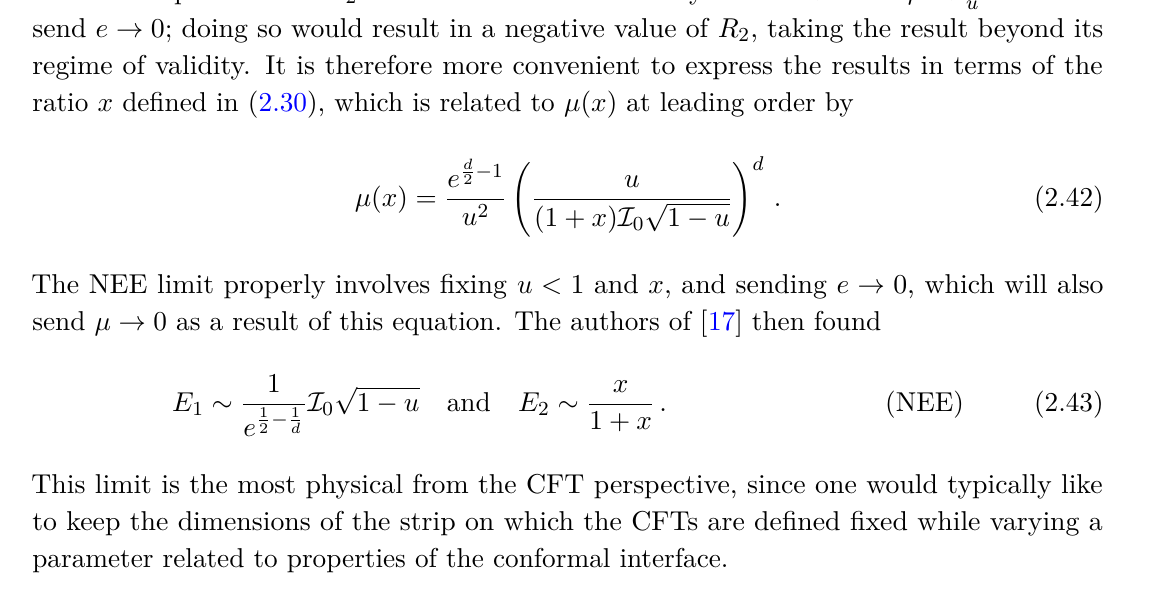
direction, while 1